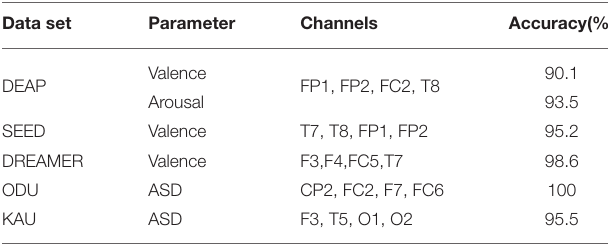
TABLE 1 | Classification results of emotions and ASD data sets using EEG